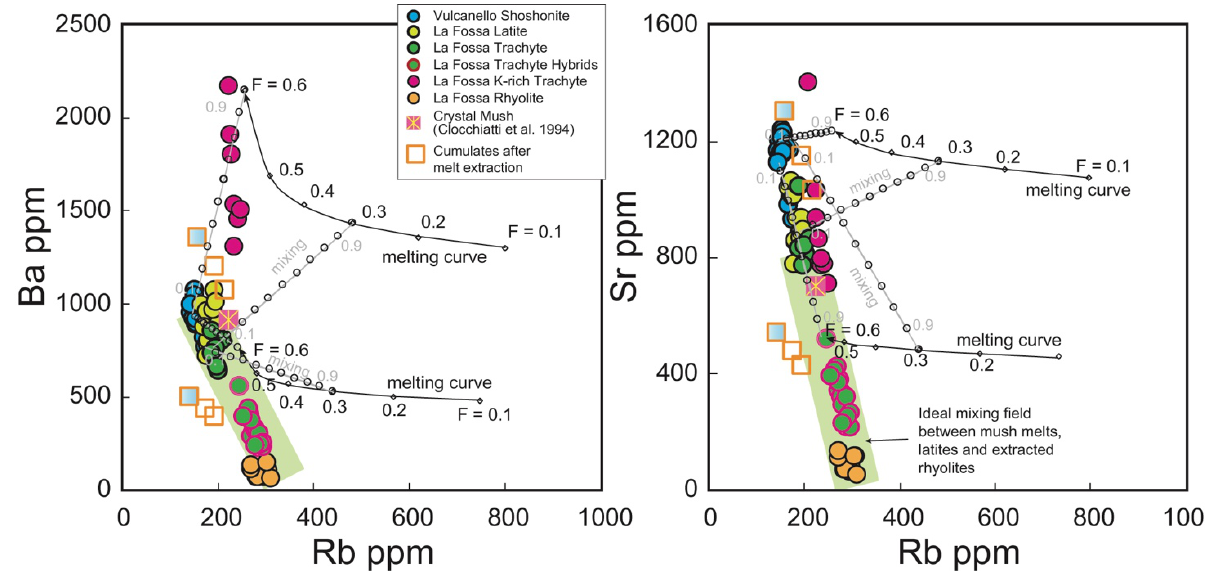
Figure 8 : Non-modal aggregative fractional melting modelling, obtained with the equations of [62], of cumulates leftover from rhyolitic melt extraction (model of Figure 7) and calculated mixing lines between mush-melts and recharging magmas represented by Vulcanello shoshonites (see Supplementary Table S9). The light blue cumulates represent the bulk compositions used for the melting simulations. F (melting curve) refer to the liquid fraction. Numbers along mixing line refer to proportion of mush melts. Mixing in variable proportion between recharging magmas, partially melted crystal mushes and the extracted rhyolites accounts for the compositional and textural features of lati-trachytic products that show evidence of mixing and for the K-Ba-rich trachyte. The ideal compositional field of these mixing processes is highlighted in green. Literature data sources as in Figure 2.